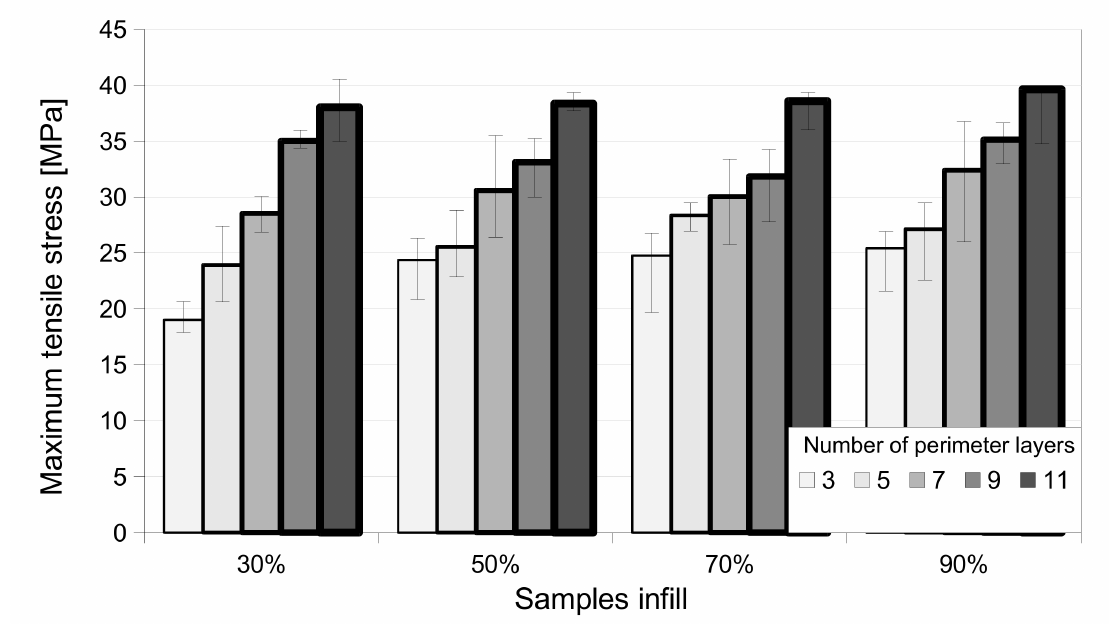
Figure 8. The influence of the number of perimeter layers shows a corresponding change in the overall density of the mechanical properties of the printed dog-bone shaped samples.